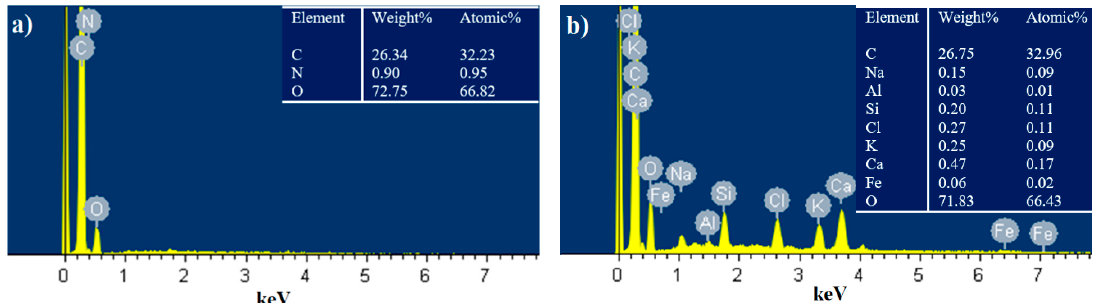
Figure 6. EDS analysis of a char residues of ( a ) PU and ( b ) WAPU-50 foams.